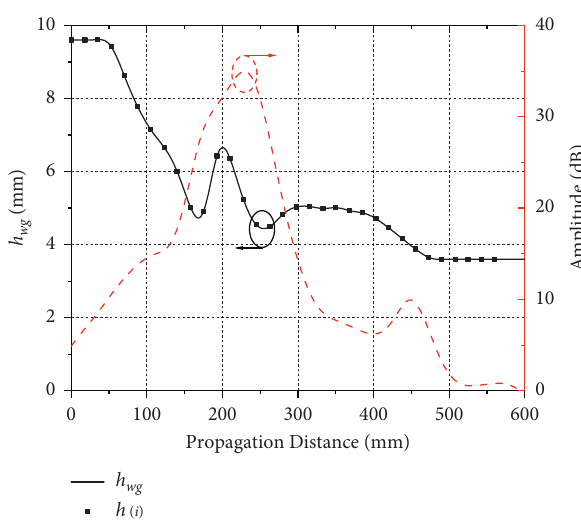
Figure 5: Height variation of the parallel plate waveguide (solid line) and antenna aperture field distribution (dotted line).